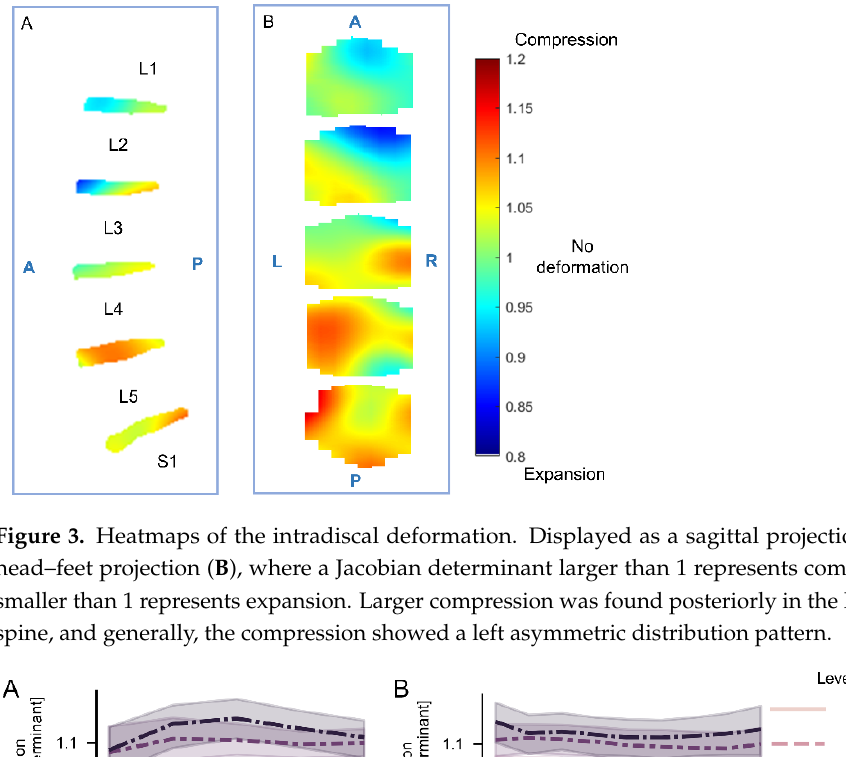
Figure 3. Heatmaps of the intradiscal deformation. Displayed as a sagittal projection ( A ), and a head–feet projection ( B ), where a Jacobian determinant larger than 1 represents compression and smaller than 1 represents expansion. Larger compression was found posteriorly in the lower lumbar spine, and generally, the compression showed a left asymmetric distribution pattern.